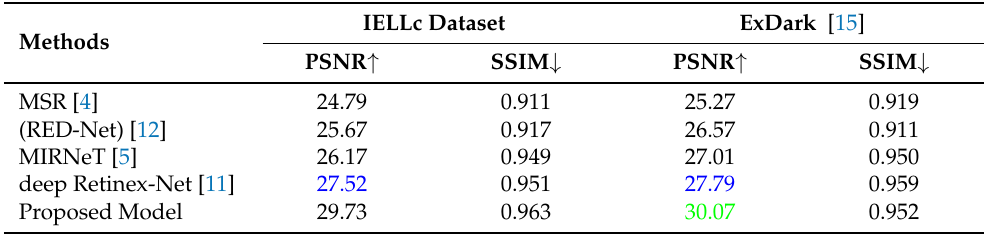
Table 3. Evaluation of the dark image enhancement performance of existing ExDark [15] and our preprocessed IELLc datasets concerning our model and existing methods.